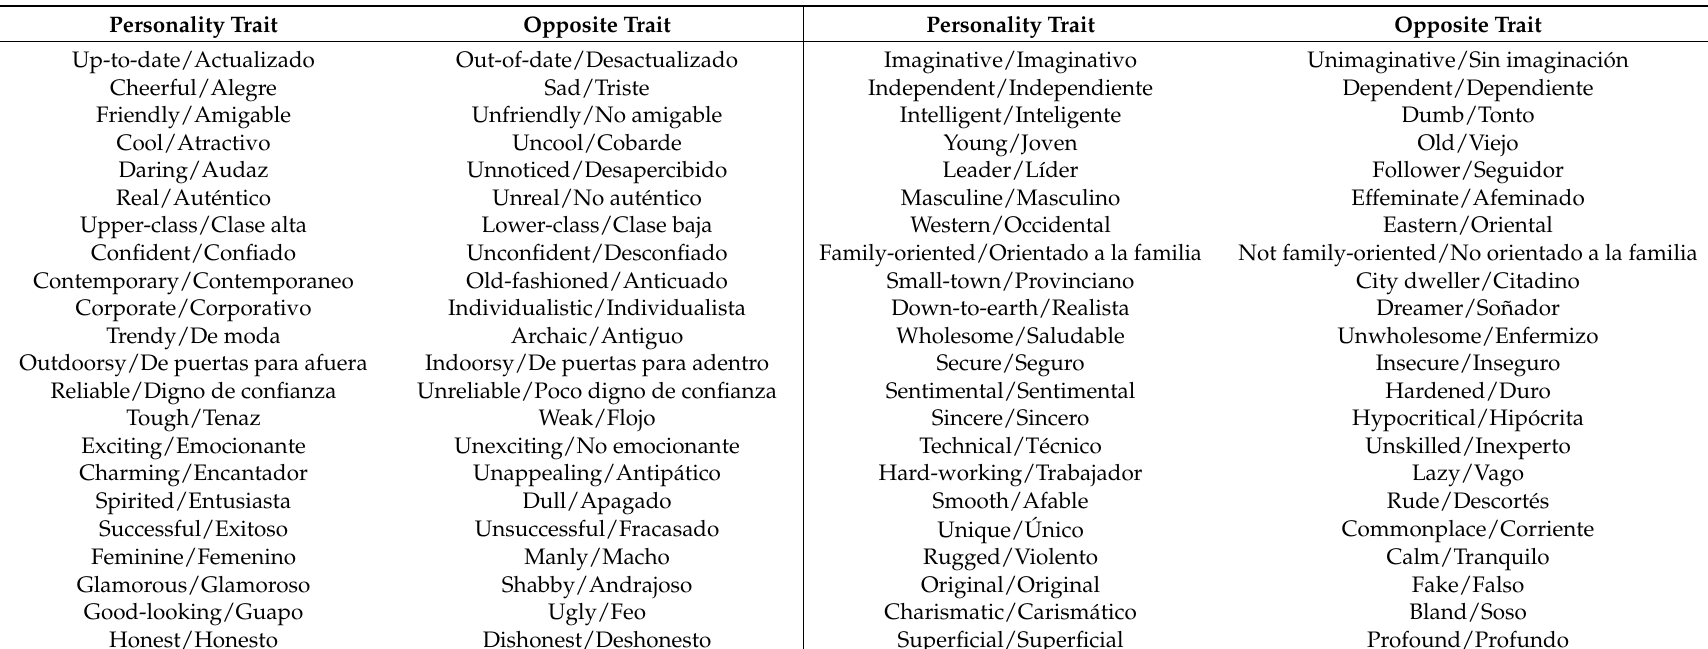
Table 2. Brand personality traits used in this study in